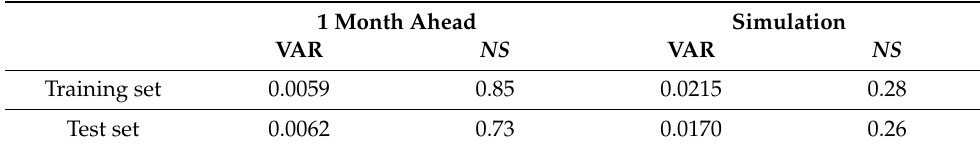
Table 4. VAR and NS values estimated for the training and testing set of data, for the one month ahead prediction and